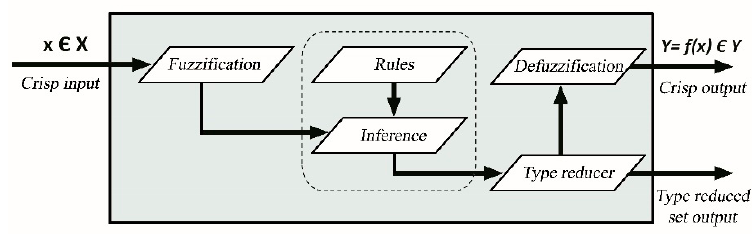
Figure 2. A schematic representation of IT2 Fuzzy System.